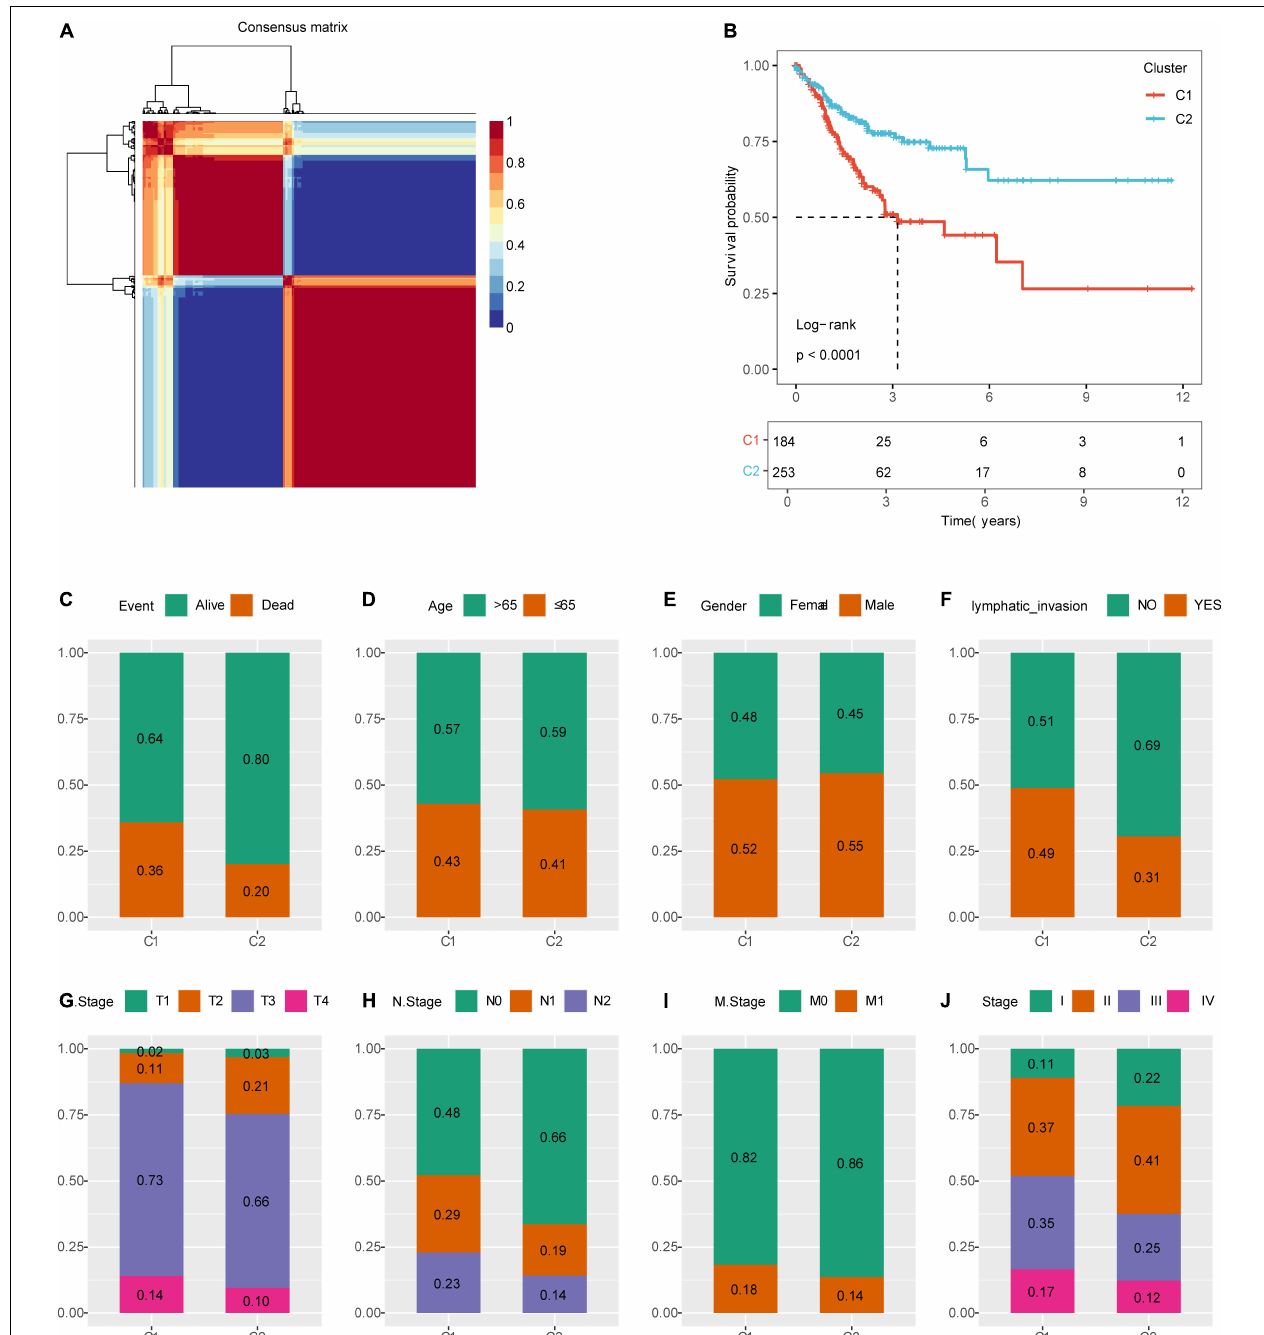
FIGURE 2 | Identification of molecular subtypes of colon cancer. (A) NMF clustering ( K = 2). (B) Kaplan–Meier (KM) curves of the molecular subtypes. (C) Comparison of the distribution of survival states among molecular subtypes. (D) Comparison of the distribution of aging states among molecular subtypes. (E) Comparison of the distribution of sex among molecular subtypes. (F) Comparison of the distribution of lymphatic invasion states among molecular subtypes. (G) Comparison of the distribution of T states among molecular subtypes. (H) Comparison of the distribution of N states among molecular subtypes. (I) Comparison of the distribution of M states among molecular subtypes. (J) Comparison of the distribution of stages among molecular subtypes.